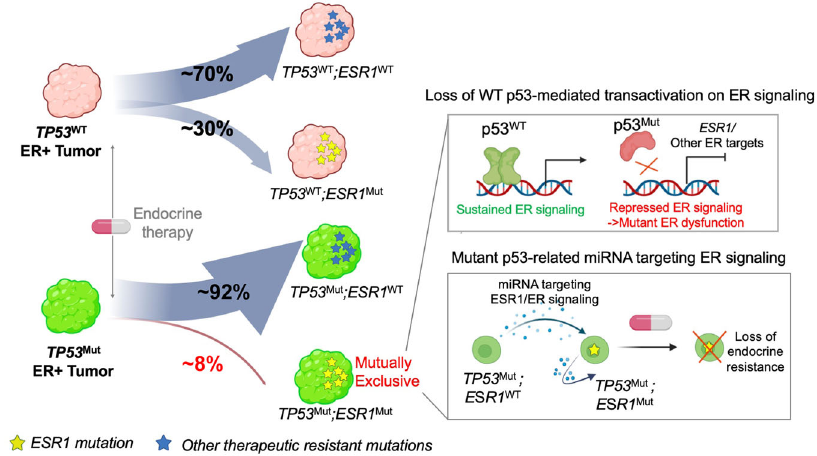
Fig. 6 Schema of proposed mechanism of TP53 - ESR1 mutation mutual exclusivity in ER + metastatic breast cancer. In the scenario of TP53 mutations as the primary driver, ER signaling is disrupted by (1) loss of WT p53 transactivation and (2) mutant p53-regulated miRNA. Thus ESR1 mutations are less frequently gained in TP53 mutant tumors. In the case of a non- TP53 mutation serving as the founder, clones acquiring ESR1 mutations could ef fi ciently outgrow under endocrine therapy and result in ESR1 mutant-dominated